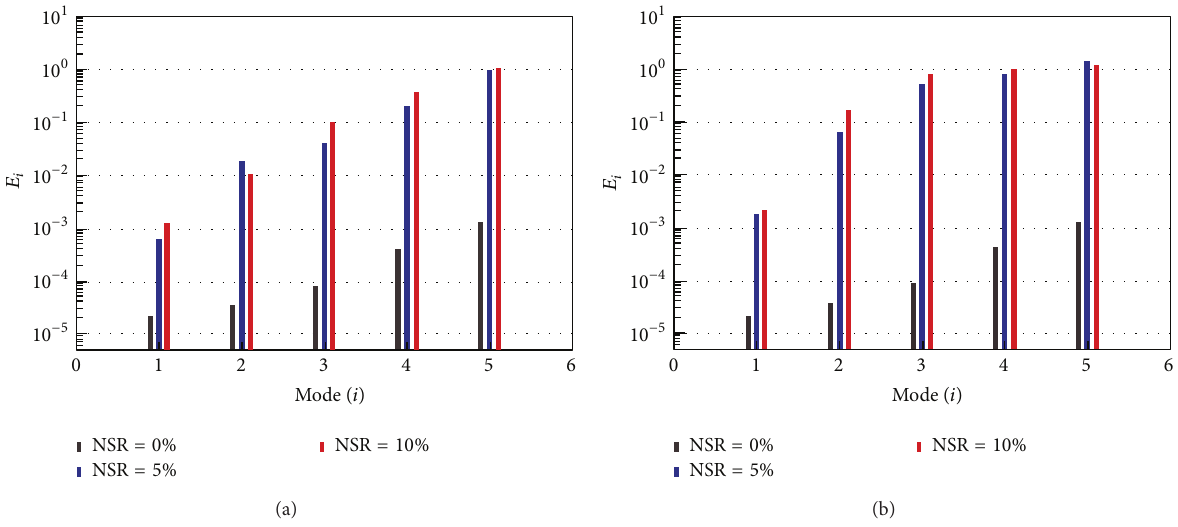
Figure 3: (a) Comparison of the error index with N4SID under various noise levels. (b) Comparison of the error index with SRIM under various noise levels.